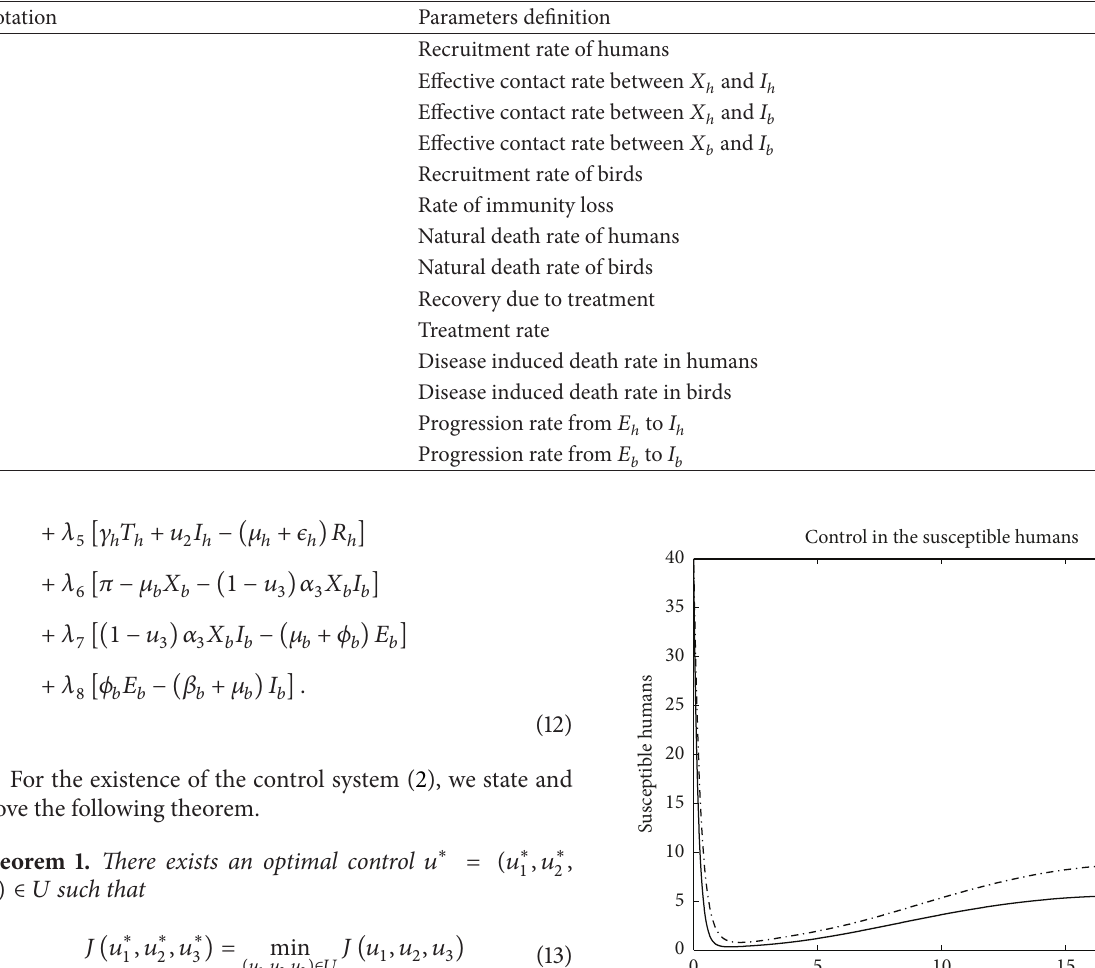
Table 1: Parameter values used for numerical simulations.